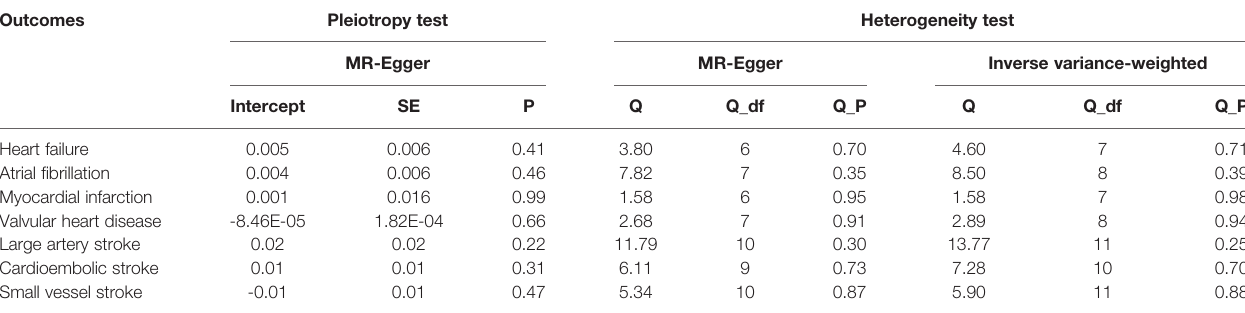
TABLE 2 | Pleiotropy and heterogeneity test of the psoriasis genetic IVs from CVD GWAS. Outcomes